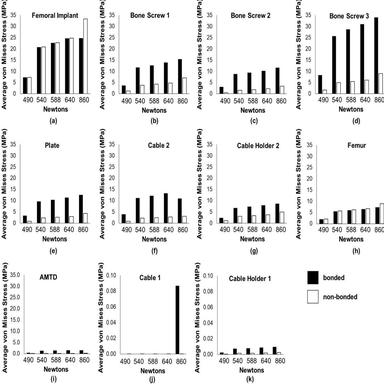
The average equivalent stresses in the (a) femoral implant, (b) bone screw 1, (c) bone screw 2, (d) bone screw 3, (e) plate, (f) cable 2, (g) cable holder 2, (h) femur, (i) AMTD, (j) cable 1, and (k) cable holders 1 of FE model for the non-bonded and bonded conditions during the standing posture of different load cases, i.e., Load case 1: 490 N, Load case 2: 540 N, Load case 3: 588 N, Load case 4: 640 N, and Load case 5: 860 N.